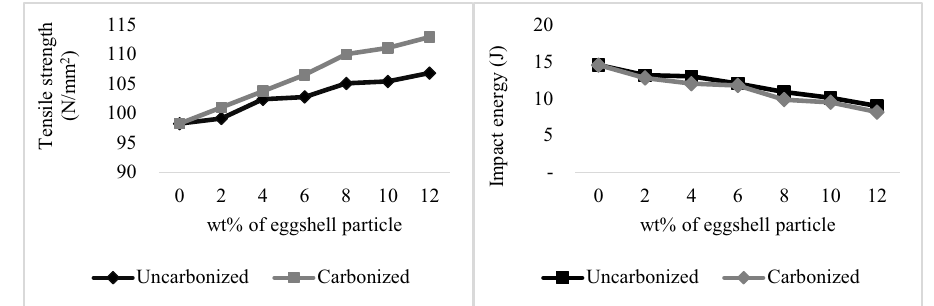
Figure 3: Comparison of tensile strength and impact energy values of raw ES particles and particles subjected to carbonation. Figures are produced based on the data in [ 58 ] .